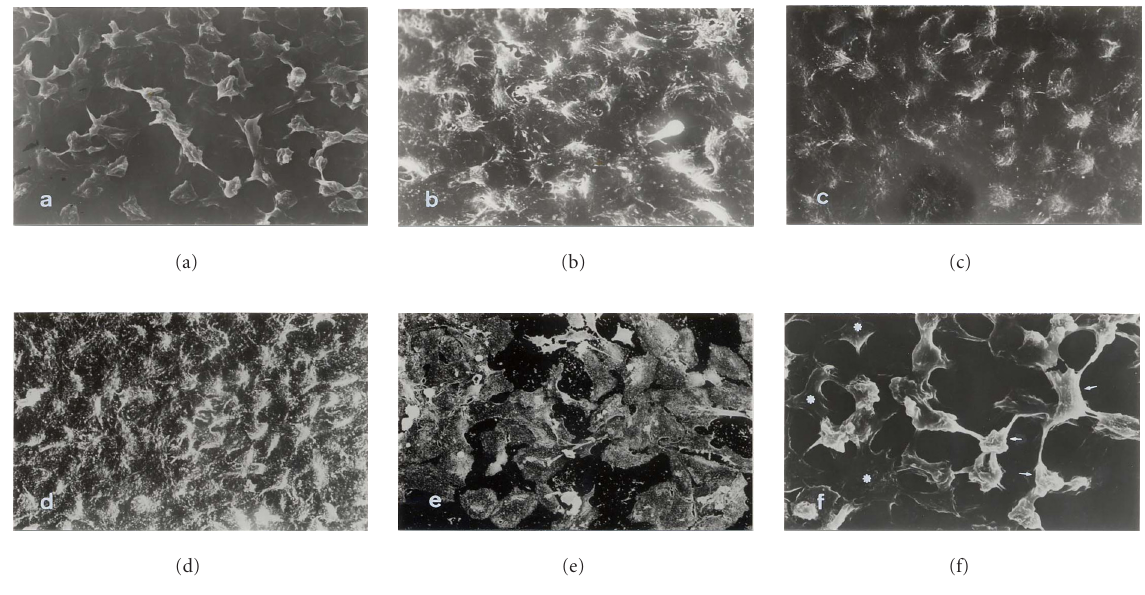
Figure 3. Scanning electron microscopy. (a) Subconfluent filtered cells showing a flattened fibroblast-like phenotype on plastic sub- stratum, OM × 250. (b) Hyaluronan addition: chondrocytes grow more three-dimensionally owing to less flattening. Cells are round, with short processes, and are separated by many intercellular spaces, OM × 330. (c) Addition of sugar extract: cells became rounded with short cellular processes, forming a compact monolayer without intercellular spaces, OM × 350. (d) Addition of large protein ex- tract: note cell-rounding, OM × 250. (e) Addition of small protein extract: cells form very small clusters with more intercellular spaces and the appearance of flattened cells, OM × 110. (f) Addition of small protein extract: two di ff erent cell morphologies are observed, one of flattened cells (asterisk) and one of widely separated rounded or star-shaped cells with incipient three-dimensional growth (arrows), OM ×